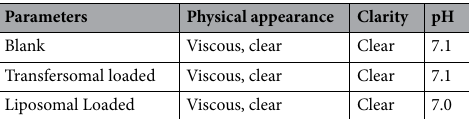
Table 6. Physiochemical properties of gel.